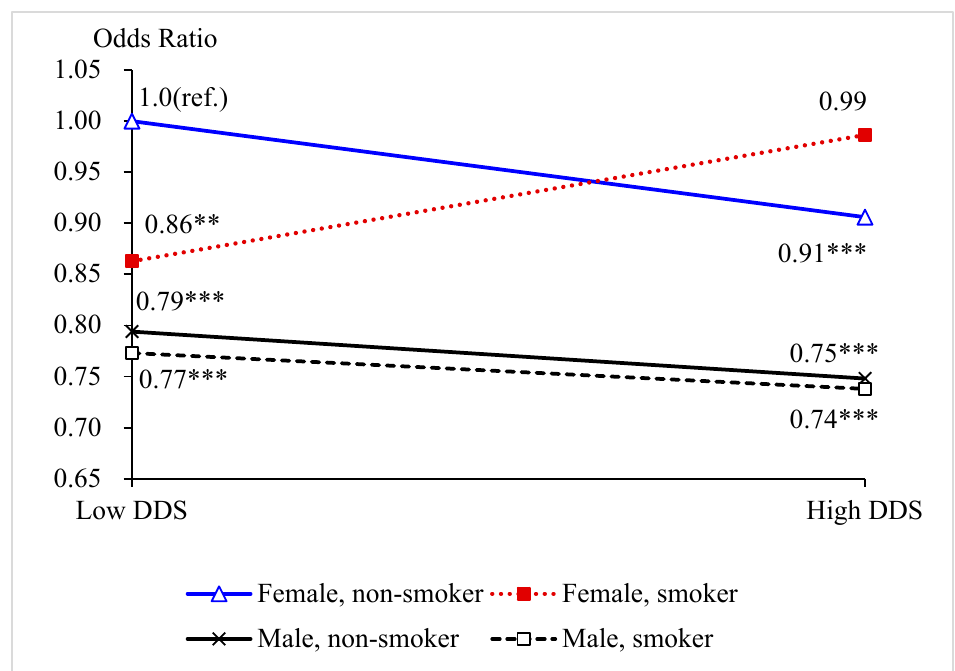
Figure 1. Odds ratios of the combinations of the statuses of DDS, smoking, and gender on cognitive impairment. Note: ** p < 0.05. *** p < 0.01. Among males, the two curves were relatively parallel, with a decreasing trend, which suggests that there was no interaction between DDS and smoking behavior (see Figure